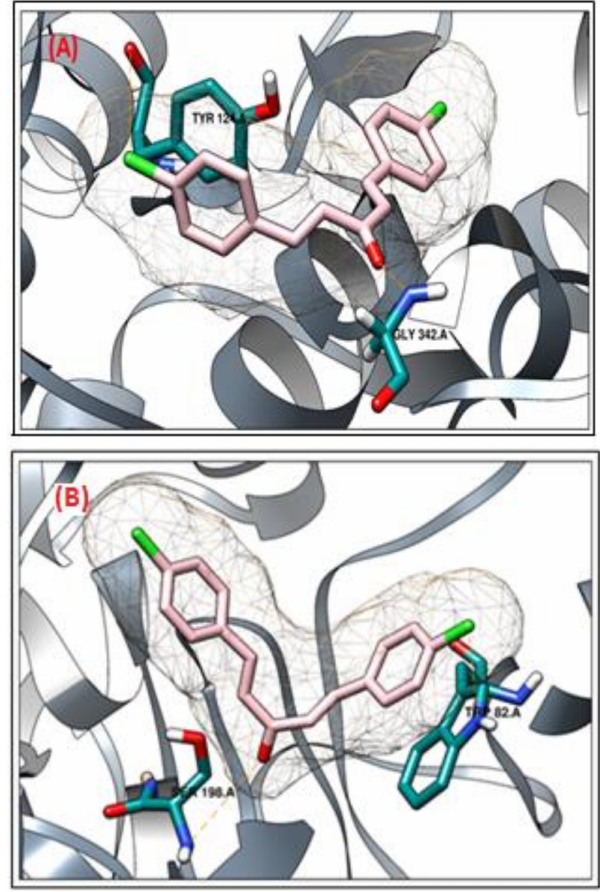
Figure 3. 3D binding mode of compound h3 against AChE ( A ) and BChE ( B )